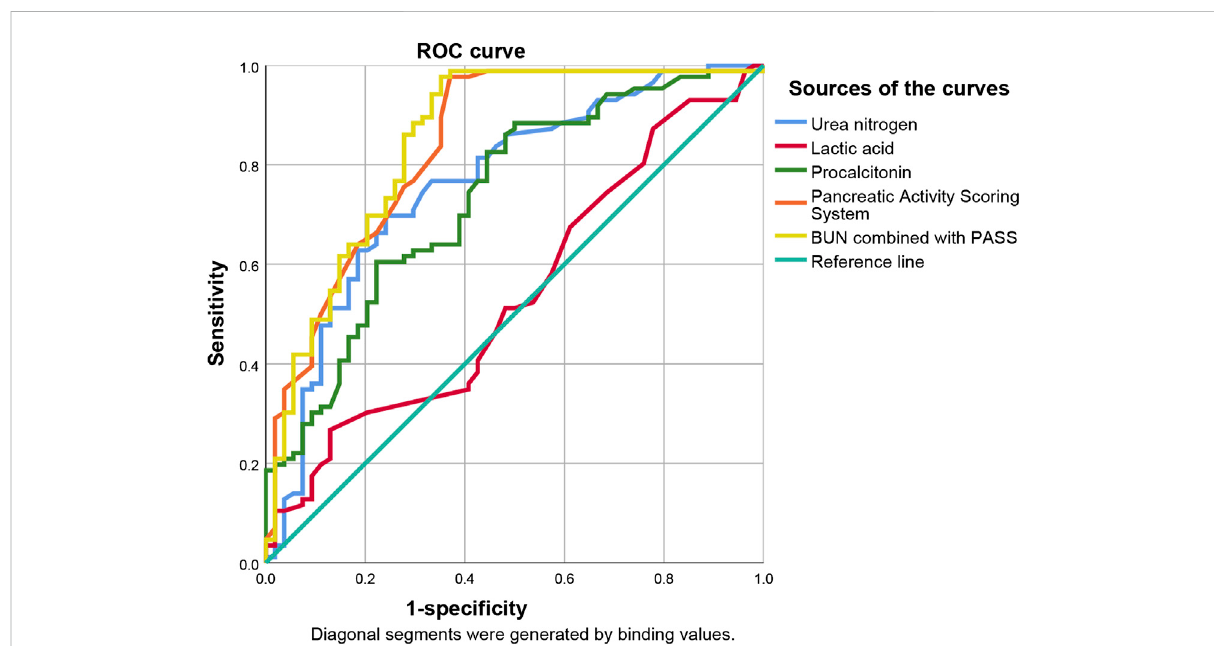
FIGURE 3 Sensitivity and speci fi city curves of PASS score in POF prediction in the presence of different cut-off values. PASS: pancreatitis activity scoring system; POF: persistent organ failure.